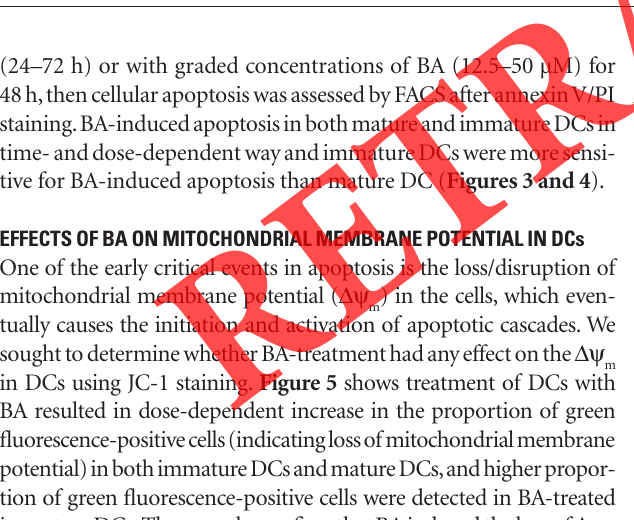
Figure 3 | Baicalin-induced apoptosis in immature and mature DCs in a time-dependent way. Immature and mature DCs were treated with 50 μM of BA for different time (24–72 h), then cells were harvested and apoptosis was assayed by flow cytometry, using annexin V/PI staining. Representative results of three independent experiments were presented.